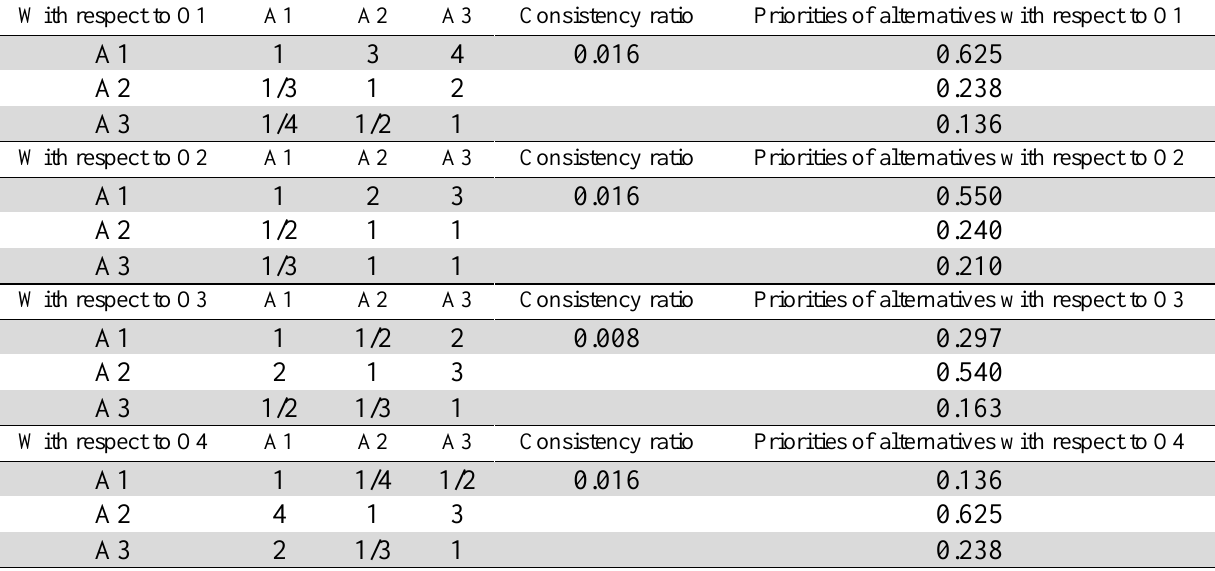
The pair-wise comparison of alternative strategies with respect to the opportunity factors With respect to O1 A1